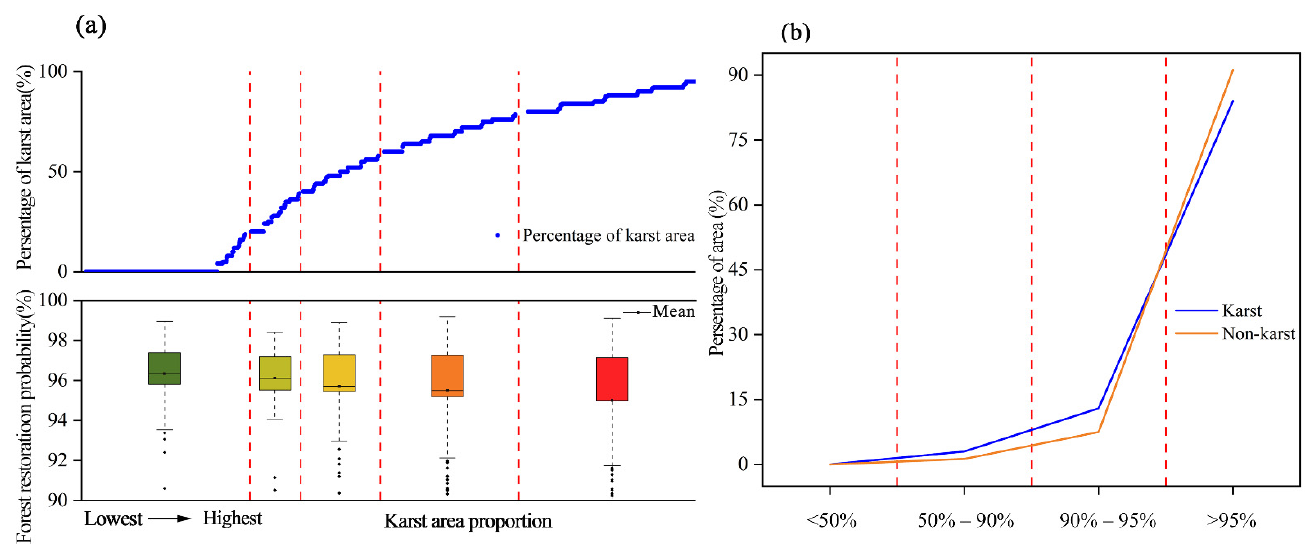
Figure 10. Analysis of the probability of forest restoration in karst and non-karst regions at the ( a ) grid and ( b ) regional scales.